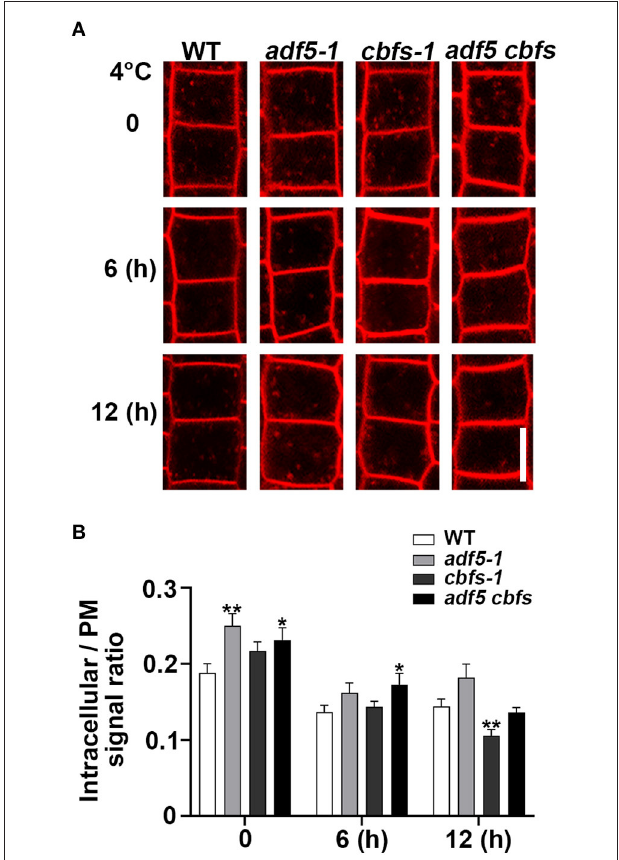
FIGURE 6 | Low temperature reduced the rate of endocytosis in mutants compared to WT. (A) Five-day-old seedlings were used for amphiphilic styryl dye FM4-64 signal intensity collection. Seedling roots of WT, adf5-1, cbfs-1, and adf5 cbfs treated at 4 ◦ C for different durations were labeled with FM4-64 to measure internalization. Scale bar = 10 µ m. (B) The rate of cytosol average fluorescence intensity to plasma membrane average fluorescence intensity. The values represent the means ± SEM ( n = 60 cells per genotype. * P < 0.05; ** P < 0.01; Student’s two-tailed t